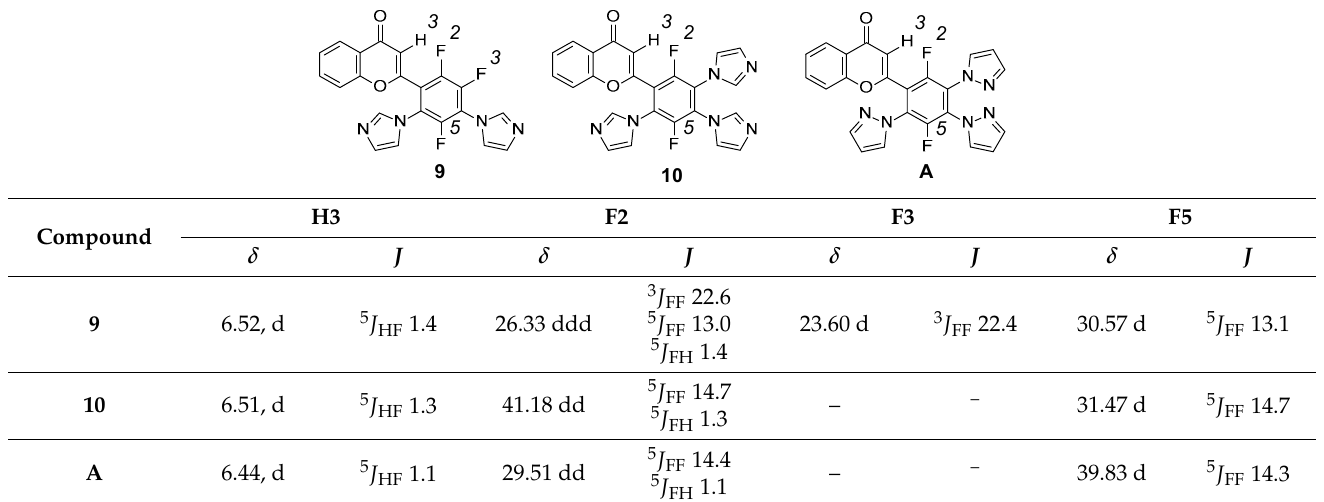
Table A1. NMR data of characteristic F and H nuclei of flavones 9 , 10 , and A .